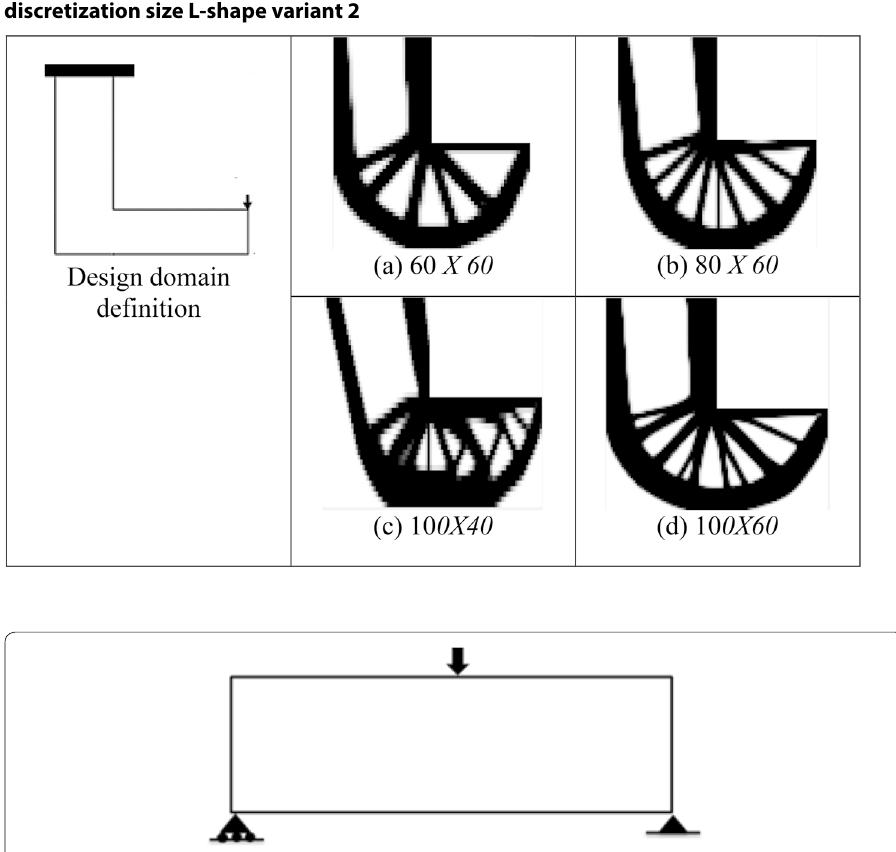
Table 2 Boundary and loading condition with respective topologies under